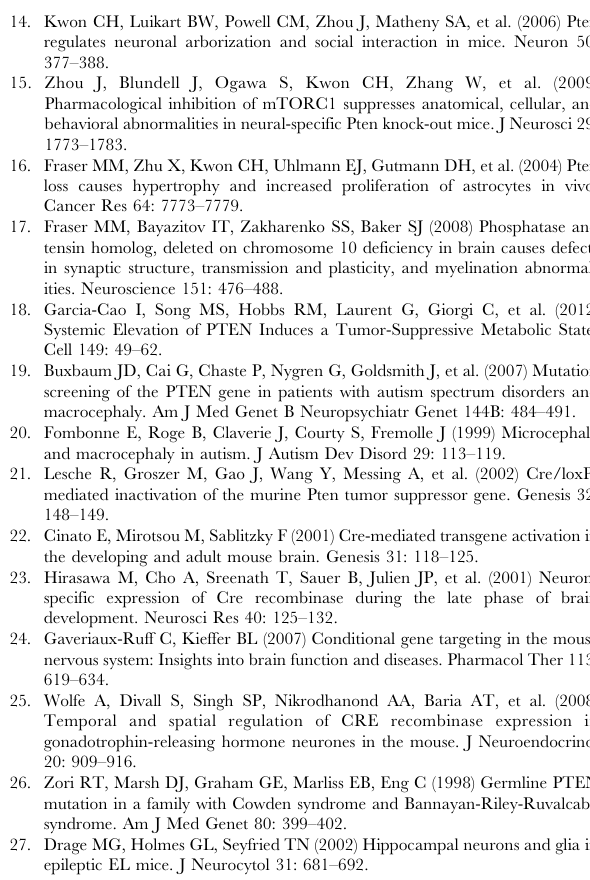
Figure S3 Pten, p53, p21 and SCO2 levels in 4–29 weeks old mice cerebellum. A . Representative Western blots of Pten, p53, p21, SCO2 and respective actin levels in 8–13 and 20–29 weeks old mice cerebella (20–30 m g protein per lane). B . Average expression of p53, p21 and SCO2 in 4–6, 8–13 and 20–29 weeks old mice cerebella. HET: white bars; HET-CRE: black bars. Statistically significant p values ( p , 0.05) calculated using Student’s t test are also shown. Figure S4 Pten, p53, and downstream effectors levels in 4–29 weeks old mice hippocampus. A . Representative Western blots of Pten, p53, p21 and SCO2 (and respective actin) levels in 8–13 and 20–29 weeks old mice hippocampus. Twenty to thirty m g of proteins were loaded per lane. B . Average expression of p53, p21 and SCO2 in 4–6, 8–13 and 20–29 weeks old mice. HET: white bars; HET-CRE: black bars. Statistically significant p values (p , 0.05) calculated using Student’s t test are also shown. Figure S5 Protein expression of p53 downstream effec- tors and CCO activity in p53 haplo-insufficient HCT 116 cells. Representative Western blots ( A ) and densitometry ( B ) of p53, p21, SCO2, Pten, MnSOD and actin (loading control) in controls and p53 haplo-insufficient HCT 116 cells. Thirty m g of protein were loaded into each lane if a 4–15% gels. MnSOD expression was normalized by the beta subunit of ATPase ( b - ATPase, mitochondrial loading control). Results are expressed as units of densitometry (AUD) normalized by actin, and reported